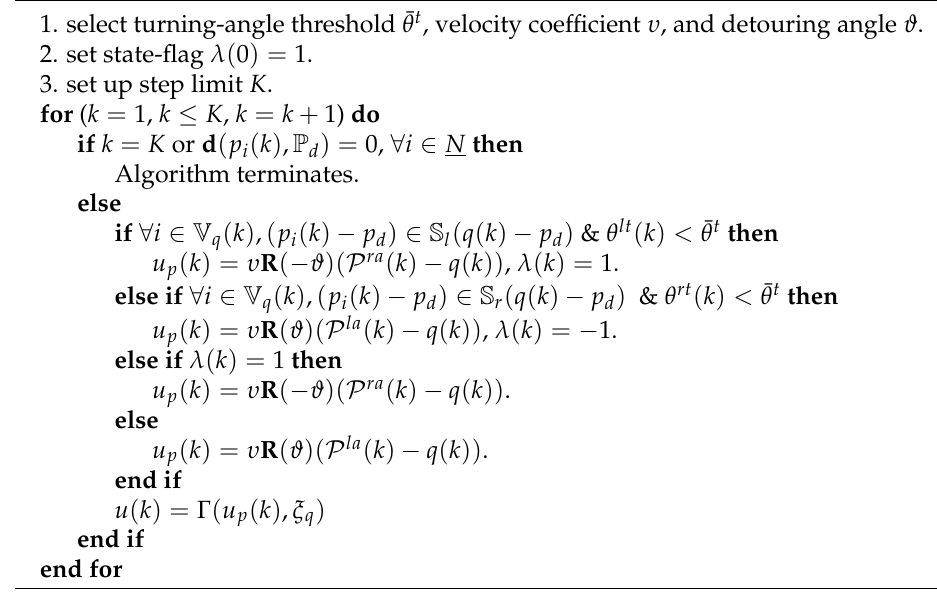
Algorithm 1 Behavior-based Herding